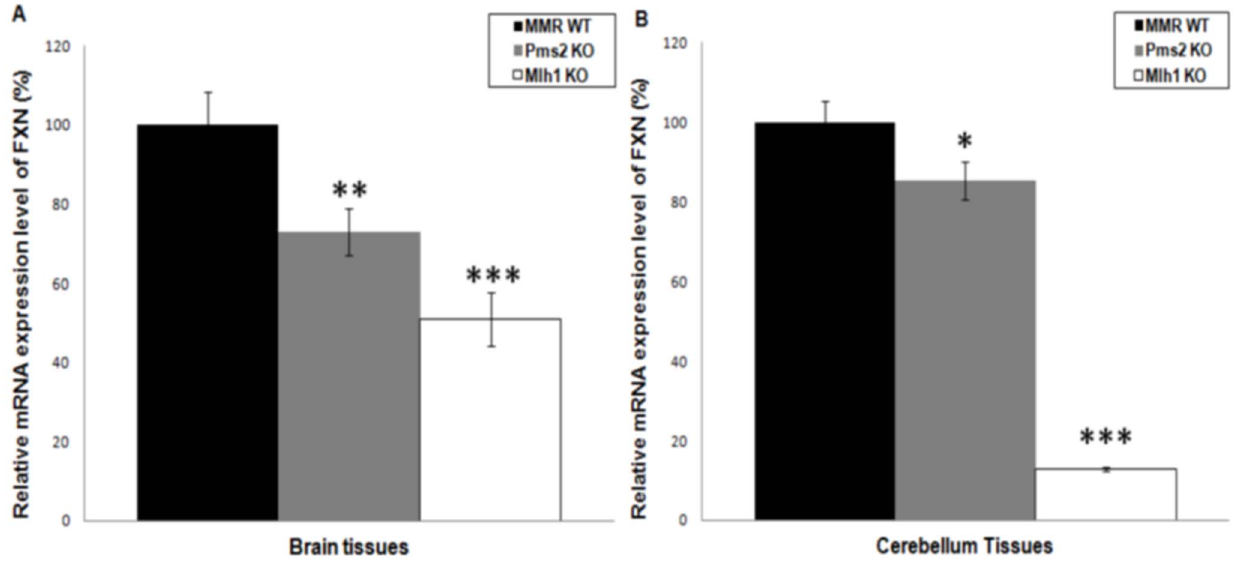
Figure 4. Effect of MutL a components on somatic FXN transcription invivo . Relative RT-qPCR analyses of somatic FXN transcription level based on the MMR genotype (WT, Pms2 KO or Mlh1 KO) in ( A ) FXN GAA / MMR brain tissues (n=2–4), and ( B ) FXN GAA / MMR cerebellum tissues (n=2–4). Statistical analysis of the experiment was perform using the student’s t test. Error bars=S.E.M, *=p , 0.05, **=p , 0.01, ***=p , 0.001.